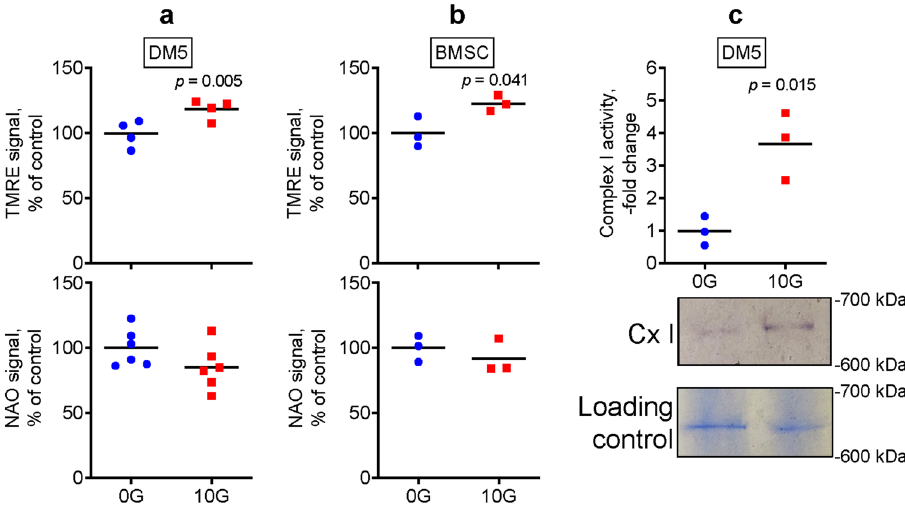
Figure 1. Electromagnetic field stimulation induces mitochondrial OxPhos in osteogenic cells in vitro. Osteogenic DM5 cells ( a ) or human BMSCs ( b ) were exposed to either an electromagnetic field at 10 Gauss (G) or left untreated (0G control). On day 4, cells were lifted and stained with either mitochondrial membrane potential probe tetramethyl rhodamine ester (TMRE) or mitochondrial mass probe nonyl acridine orange (NAO), as described in detail in the Methods. Fluorescence was assayed with flow cytometry; ( c ) DM5 cell lysates were run on a non-denaturing clear-native gel. Gels were exposed to enzymatic colorimetric mitochondrial respiratory complex I (Cx I) assay. Cx I signal was measured and normalized to loading controls stained with Coomassie Blue. A representative gel image is shown below the graph. Uncropped images are shown in Supplementary Fig. S1a. Plots show actual data points and calculated means. P value was determined via the t